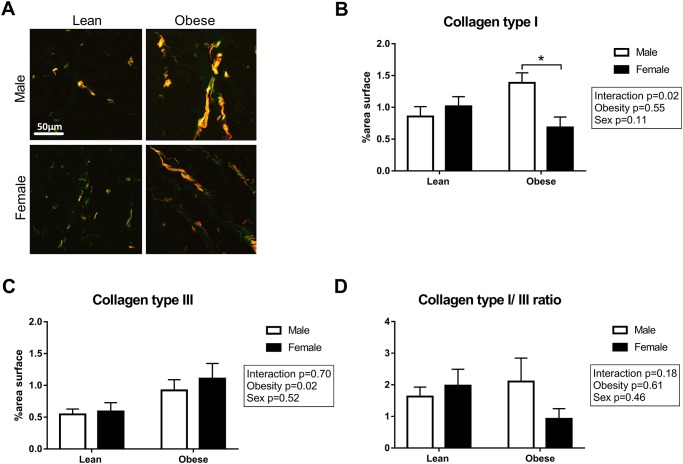
Obesity leads to an increase in collagen type III fibres.A) Representative images and the percentage of B) collagen type I fibres and C) type III fibres per myocardial area. D) Additionally, the collagen type I to type III fibre ratio was calculated in ZSF1 rats. N = 4-7/group. *P<0.05.